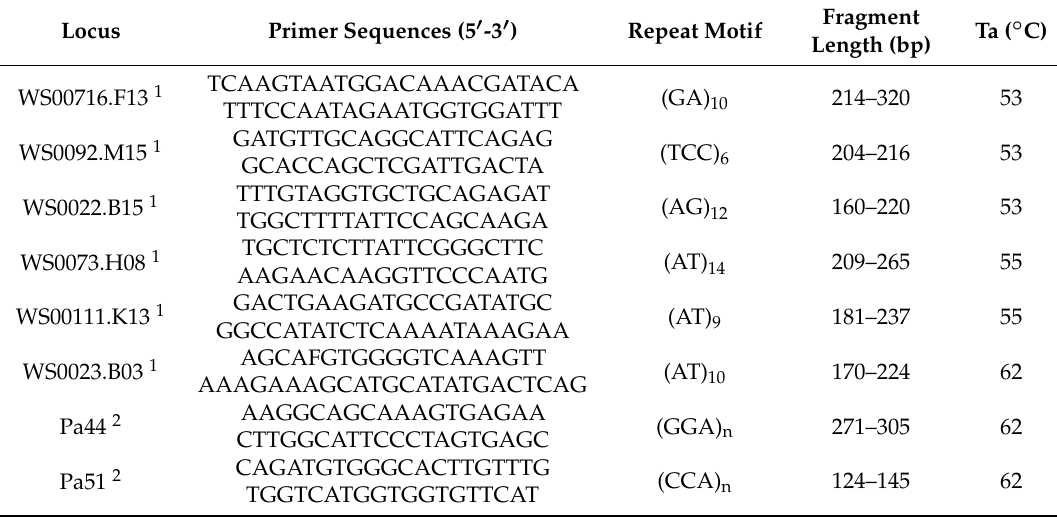
Table 2. Analyzed loci of Norway spruce populations, sequences of microsatellite primers, repeat motifs, fragment length (bp), and specific primer annealing temperatures